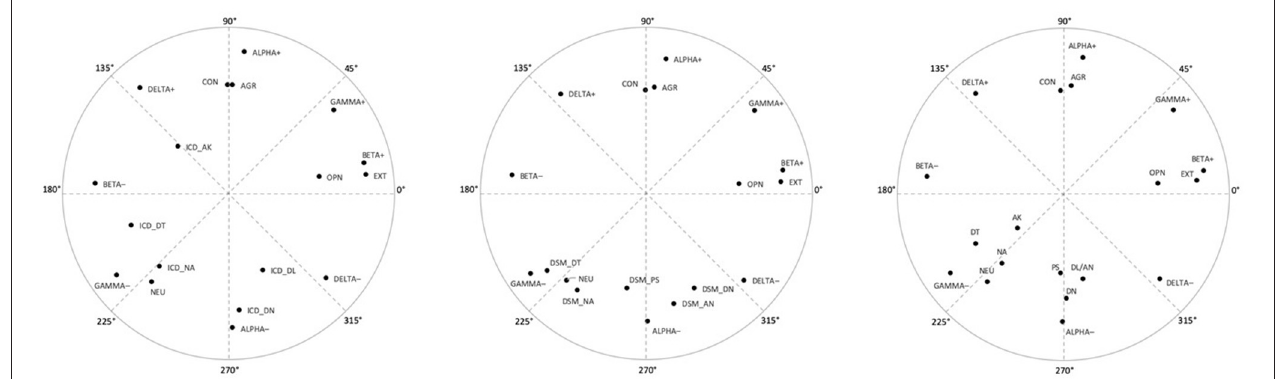
FIGURE 4 | Factor loading plots in Study 1 ( N = 242) for: (Analysis A) CPM metatraits, FFM and ICD-11 traits; (Analysis B) CPM metatraits, FFM and DSM-5 traits; and (Analysis C) CPM metatraits, FFM and the six-domain model traits (placed at left, middle, and right, respectively). NA, Negative Affectivity; DT, Detachment; DN, Disinhibition; DL, Dissociality; AN, Antagonism; AK, Anankastia; PS, Psychoticism; NEU, Neuroticism; EXT, Extraversion; AGR, Agreeableness; CON, Conscientiousness; OPN, Openness to Experiences; + denotes the positive pole of a metatrait; – denotes the negative pole of a